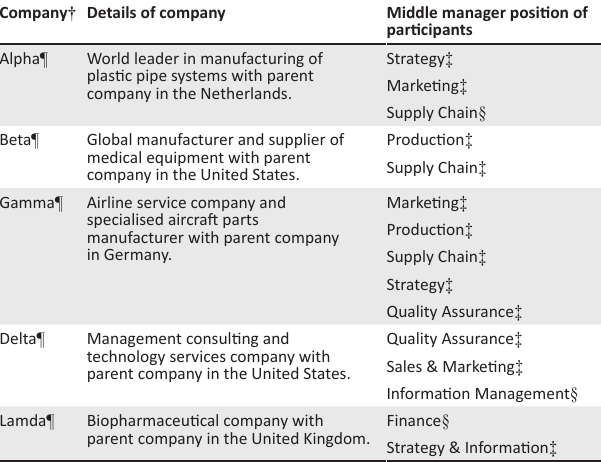
TABLE 1: Participant characteristics.